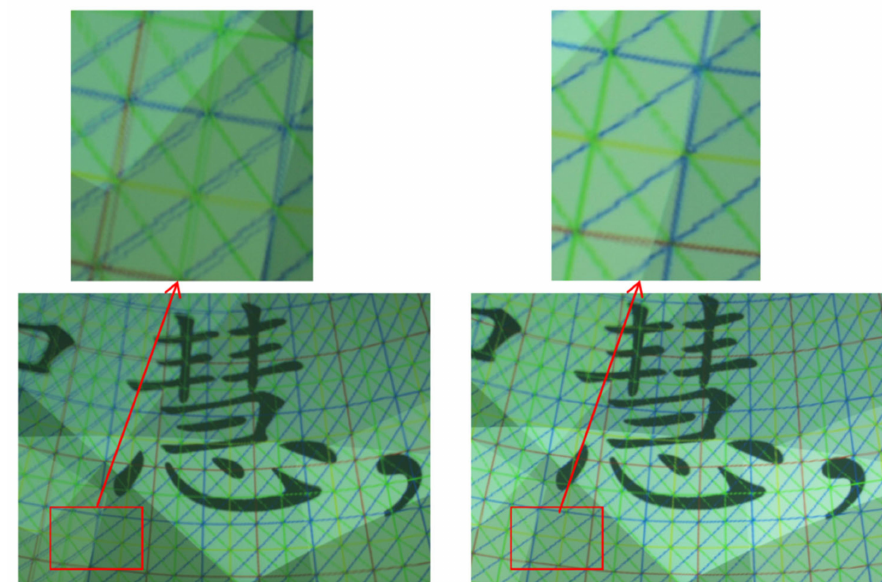
Figure 16. Fourteen-grid stitching effect of the algorithm in [13] and the method proposed in this paper (the right image is based on the method proposed in this paper).